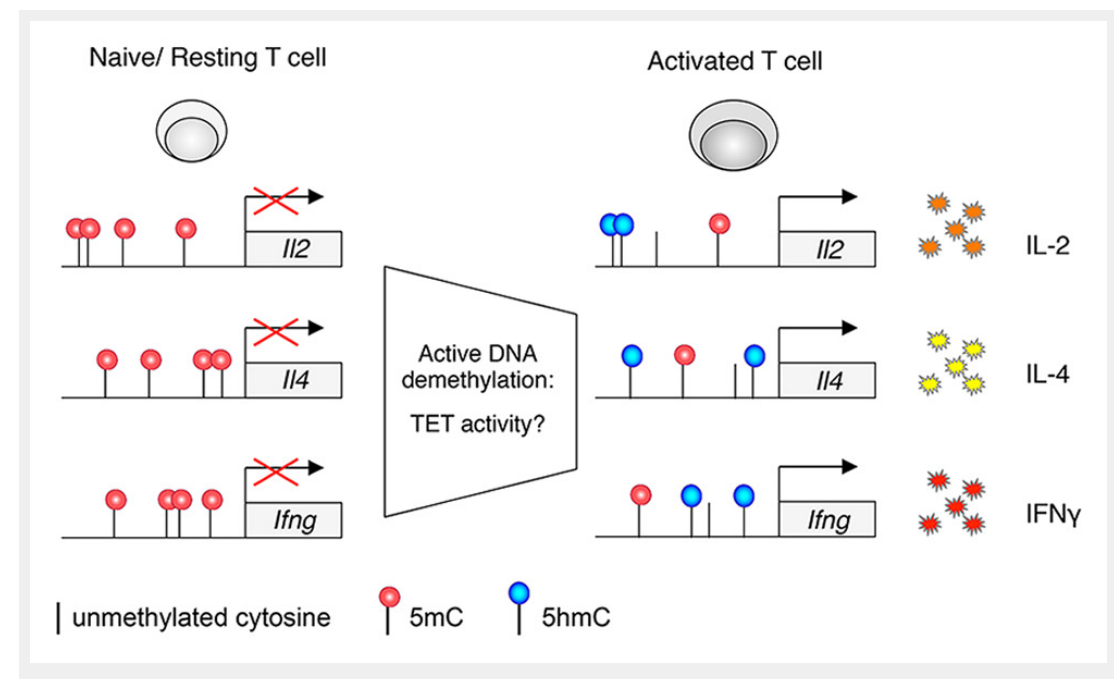
Figure 2 DNA methylation dynamics regulate cytokine production in T lymphocytes. DNA methylation modulates cytokine production upon T cell activation, and active demethylation processes (independent of cell replication) have been shown to act at some cytokine loci. Hypothetically, these processes may involve TET proteins as an underlying mechanism of demethylation. 5hmC = 5-hydroxymethylcytosine; 5mC = 5.methylcytosine; IFNγ = interferon-gamma; IL = interleukin; TET = ten-eleven